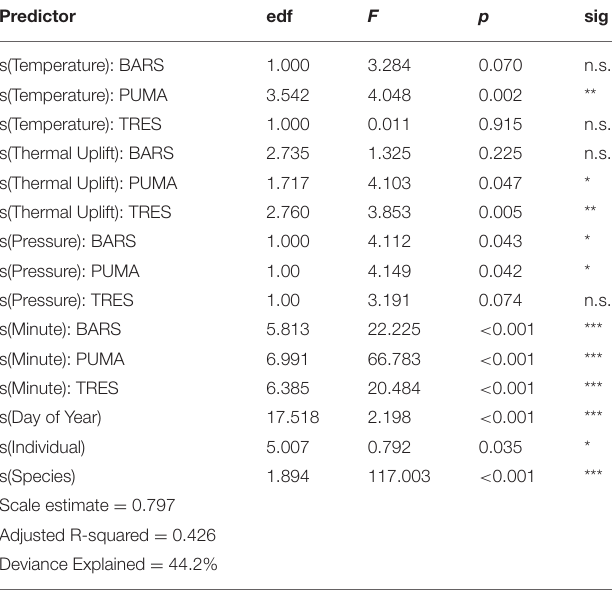
TABLE 2 | Results of the Generalized Additive Mixed Model (GAMM) analyzing flight altitude and atmospheric condition predictors.